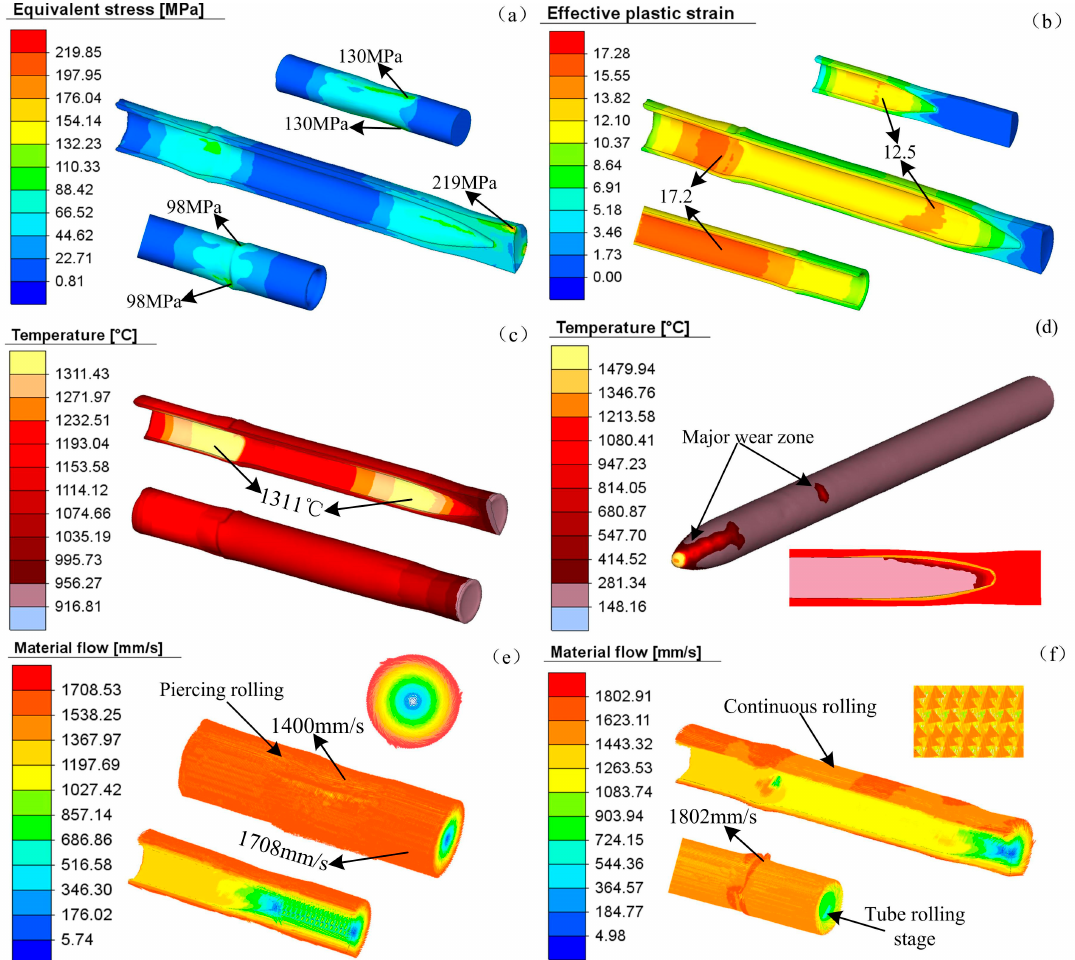
Figure 7. Various deformation laws in the TSR process: ( a ) stress filed; ( b ) strain field; ( c ) temperature field of the tube; ( d ) temperature field of the plug and mandrel; ( e ) velocity field during piercing and ( f ) velocity field during rolling.